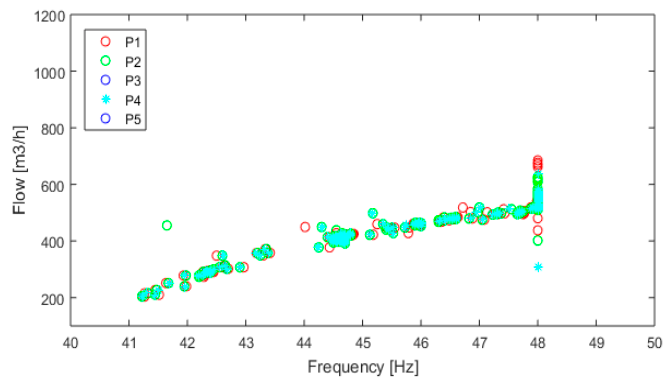
Figure 12. The characteristic F = f ( P i ) for the hydraulic regime with three pumps in operation.